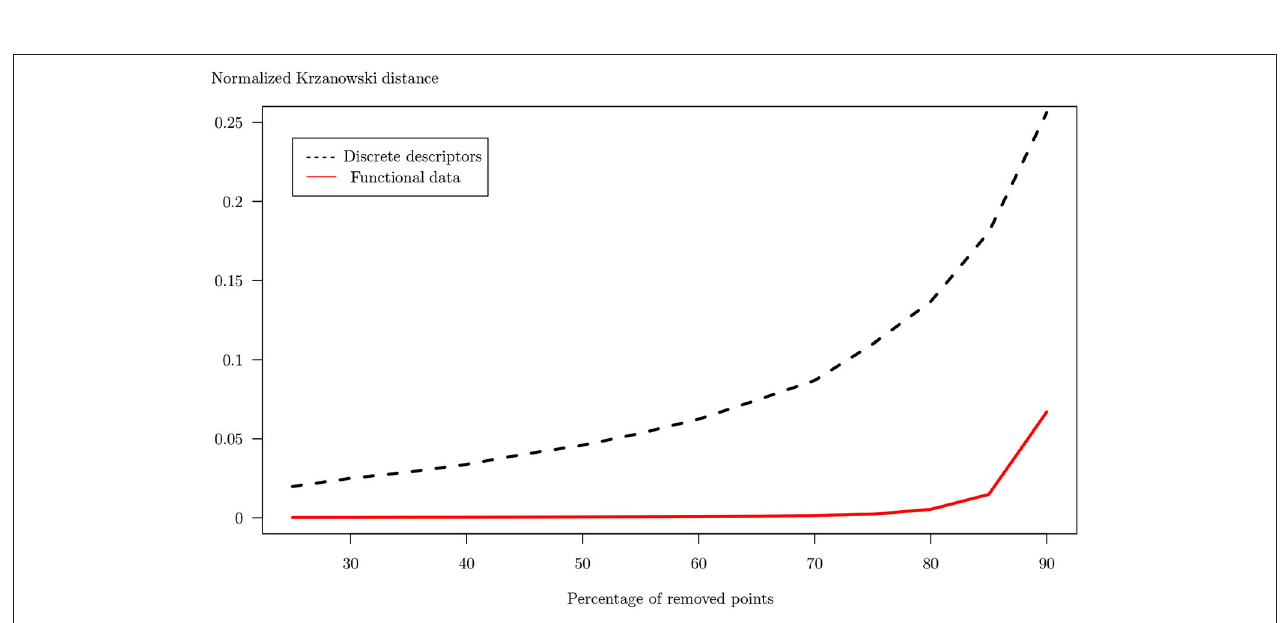
FIGURE 10 | Boxplots of the number of estimated prey capture events per cluster. Labels identify the three major categories of diving behaviors.